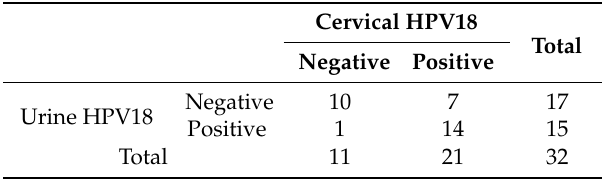
Table 3. Urine HPV18 versus cervical HPV18 positivity. κ : 0.510, p =